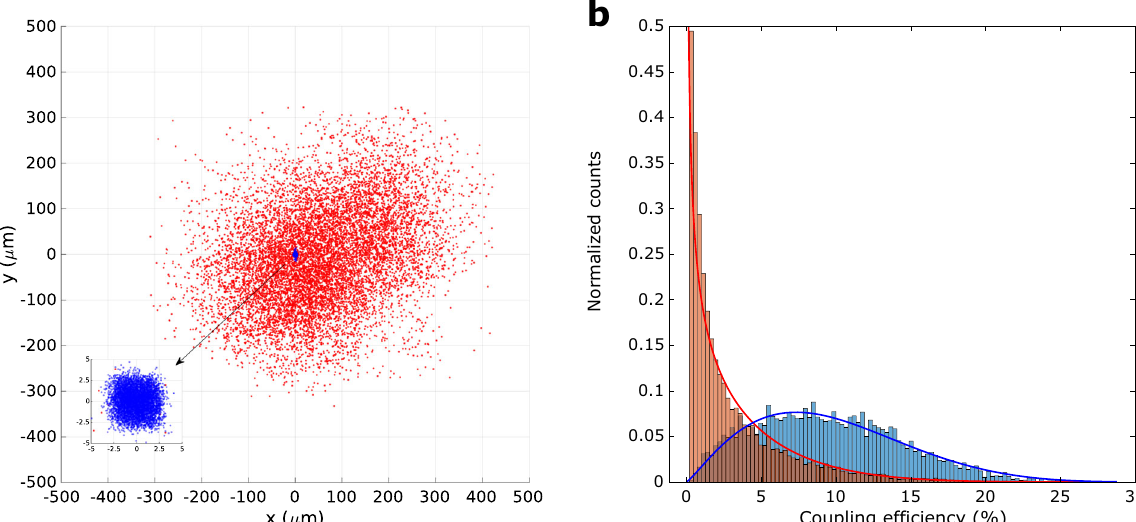
Fig. 4 Results for PAT data collected on April 17th, 2019 at 12:30 (CEST). a Centroid fl uctuations on the PSD. b Histogram of the power coupled into the SMF. The plots present both data without (red) and with (blue) tip/tilt correction, with the corresponding coupling ef fi ciency